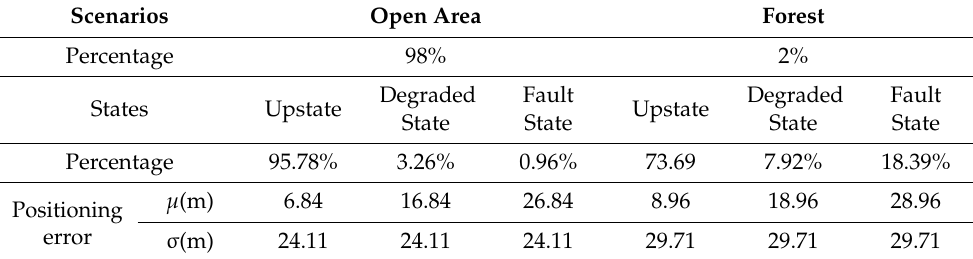
Table 4. Statistics of GNSS positioning errors.